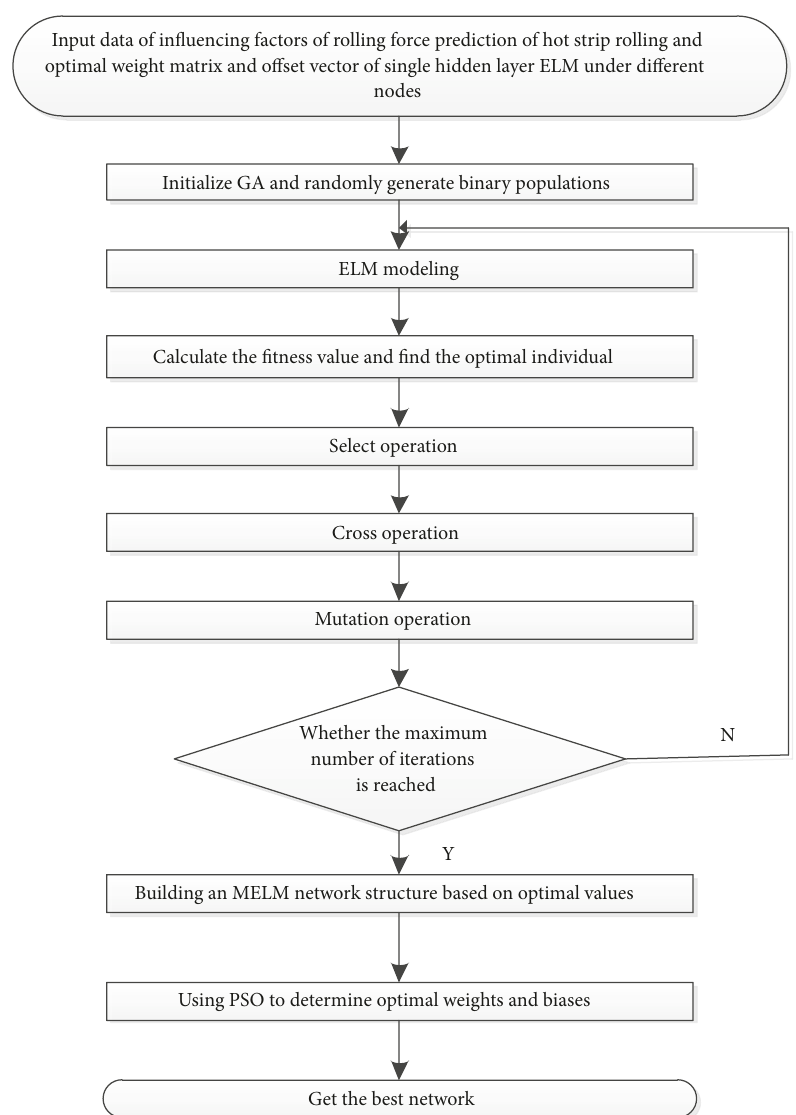
Figure 3: The workflow of the proposed PSO-GA-MELM